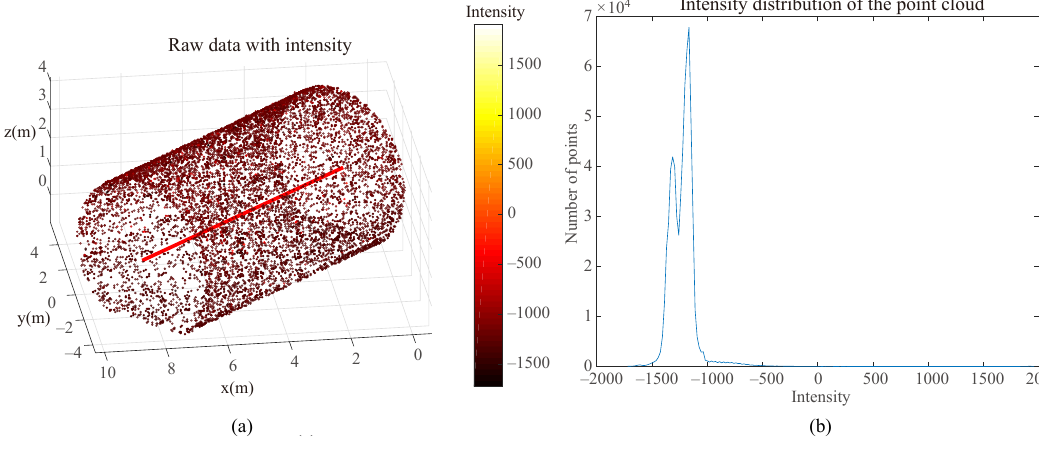
Figure 11. Intensity distribution of the raw point clouds in the experiments: ( a ) illustrates the three-dimensional spatial distribution of the tunnel point cloud about intensity; ( b ) illustrates the quantity distribution of the tunnel point cloud about